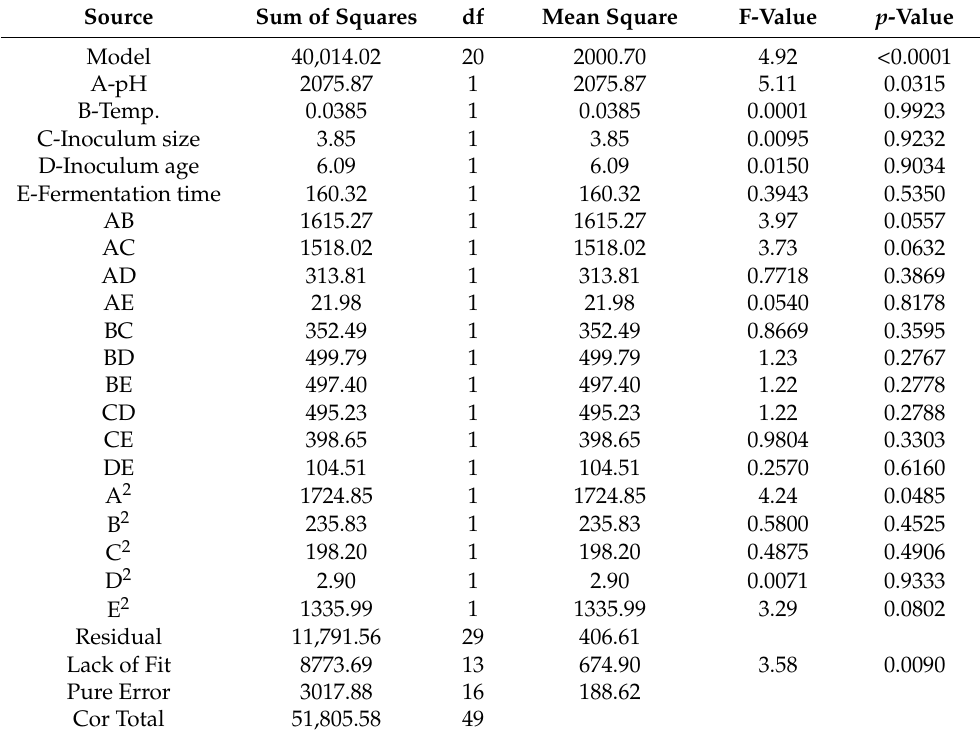
Table 3. Central Composite Design (CCD) model of lovastatin by Analysis of variance (ANOVA)